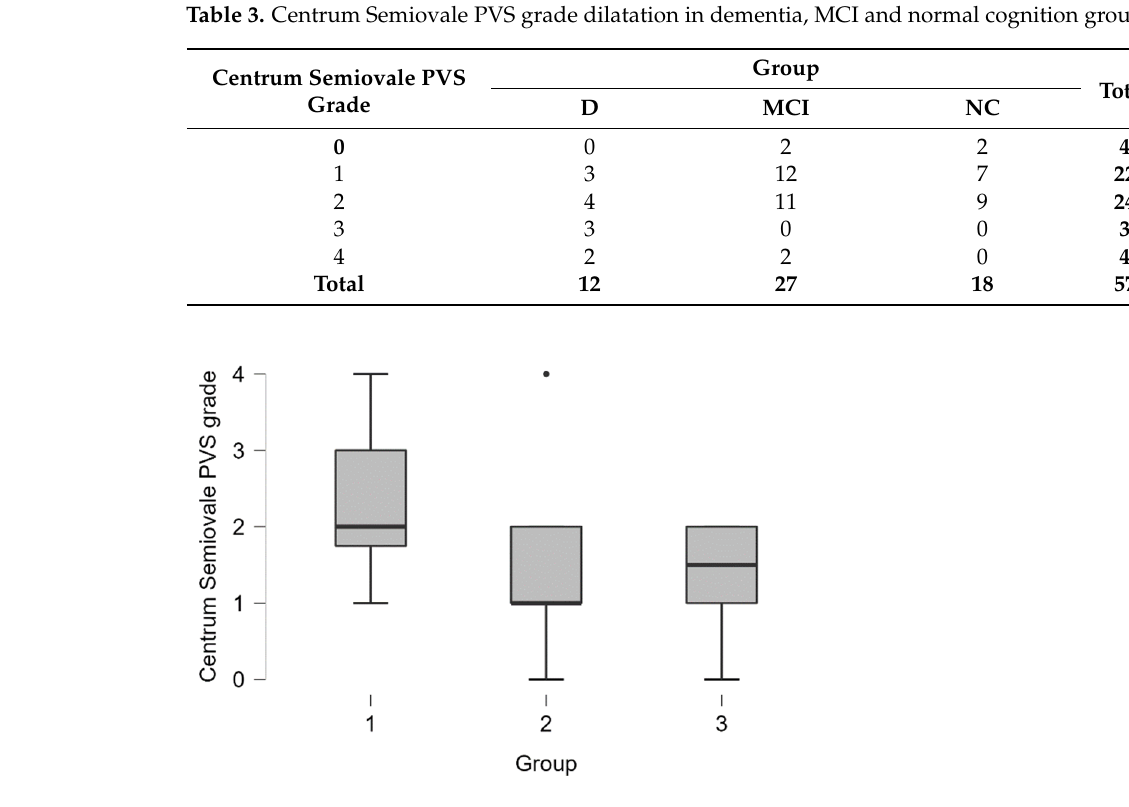
Figure 6. Centrum semiovale PVS dilatation grade boxplot in (from left to right) dementia, MCI, and normal cognition groups (black dot–outlier).